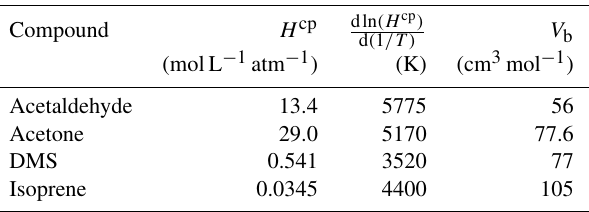
Table A3. Fresh water solubility ( H cp ), solubility temperature dependence ( dln (H water solubility and Schmidt number at ambient temperature and salinity. H cp and dln (cid:0) H cp (cid:1) / d ( 1 /T ) for freshwater are updated from Sander (2015) and Burkholder et al. (2015).